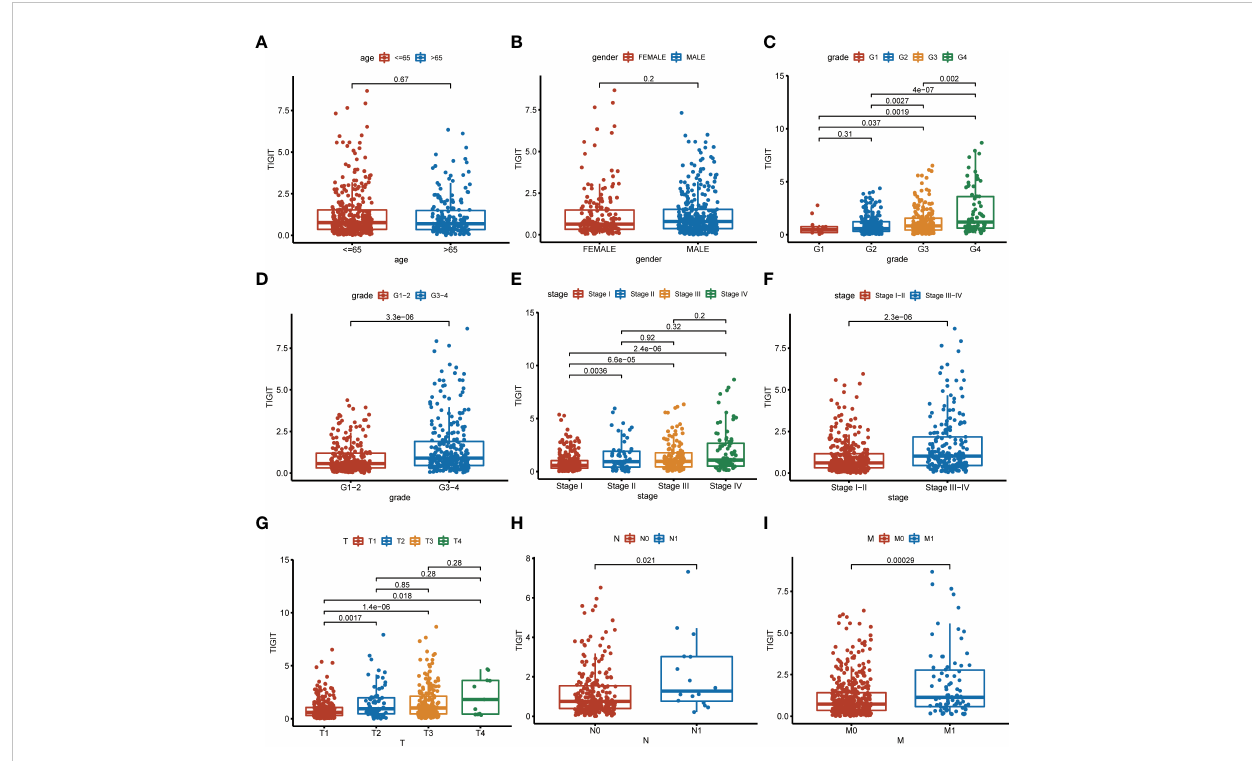
FIGURE 5 Clinical correlation of TIGIT expression. (A) clinical correlation between age and TIGIT. (B) clinical correlation between gender and TIGIT. (C) clinical correlation between grade and TIGIT. (D) clinical correlation between grade and TIGIT. (E) clinical correlation between stage and TIGIT. (F) clinical correlation between stage and TIGIT. (G) clinical correlation between T stage and TIGIT. (H) clinical correlation between N stage and TIGIT. (I) clinical correlation between M stage and TIGIT.